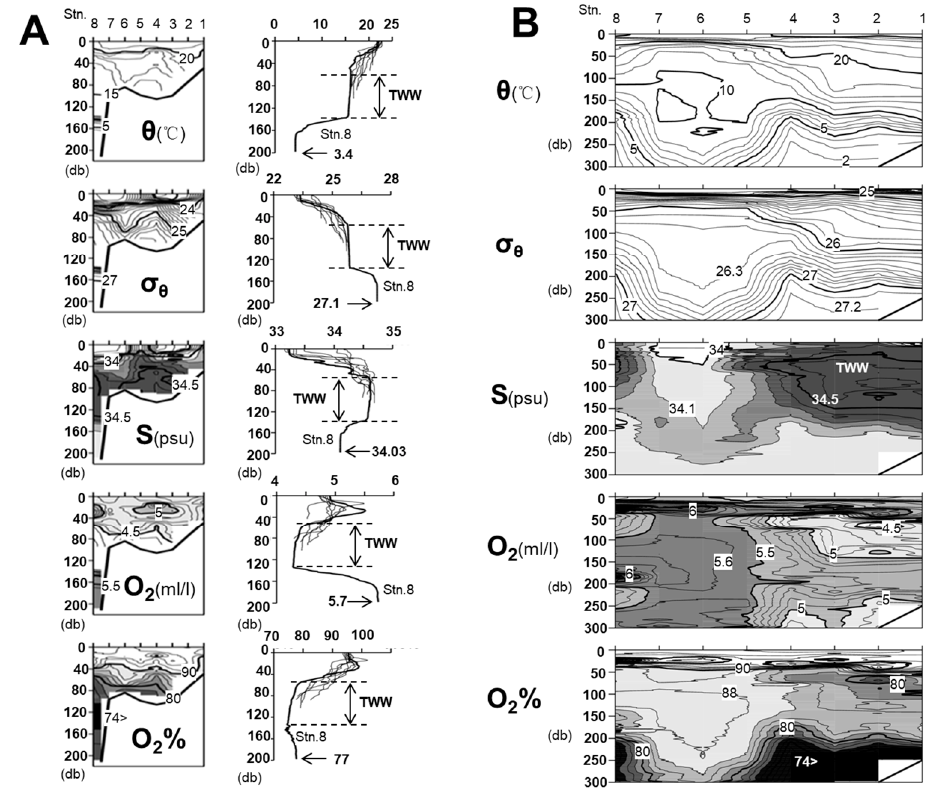
Figure 7. Vertical cross-sections of θ , σ θ , S, O 2 and O 2 % along line ( A ) and ( B ) in June, 2011.